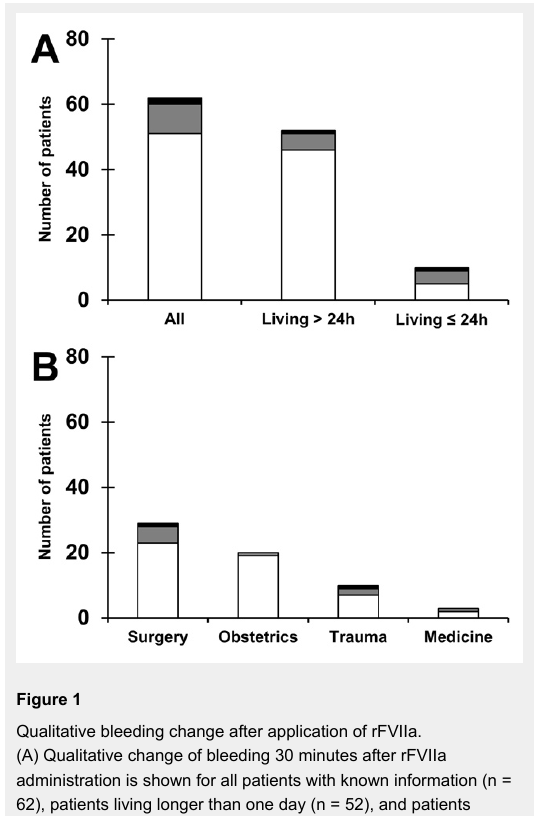
Figure 1 Qualitative bleeding change after application of rFVIIa. (A) Qualitative change of bleeding 30 minutes after rFVIIa administration is shown for all patients with known information (n = 62), patients living longer than one day (n = 52), and patients deceased within 24 hours after application of rFVIIa (n = 10). (B) Same information according to patient category. Patients with decreased bleeding are shown in white, patients without change of bleeding are shown in grey, and patients with increased bleeding after rFVIIa are shown in black.